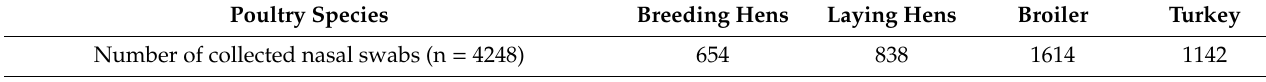
Table 4. Resistance profiles of 252 MRSA isolates (one isolate per farm) recovered from breeding hens, laying hens, broilers, and turkeys on poultry farms in Algeria from 2011 to